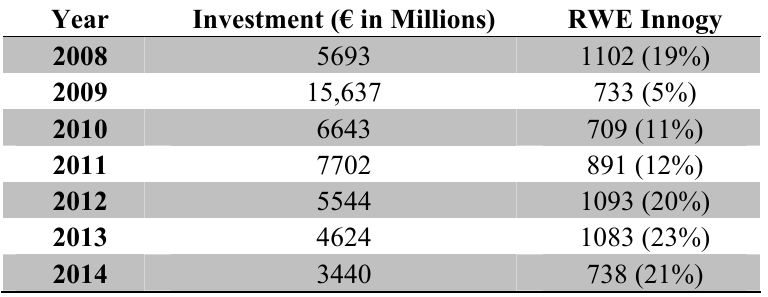
Table 6. RWE–overall investment and share of investment in renewables [49,57–61].